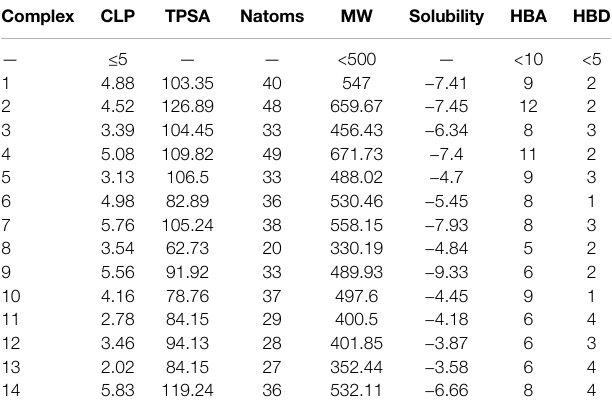
TABLE 3 | Wavelength (nm), oscillatory strength ( f ), and number of transitions for 14 multikinase inhibitors. S. No. Wavelength (nm) Oscillatory strength (f) Numberoftransitions